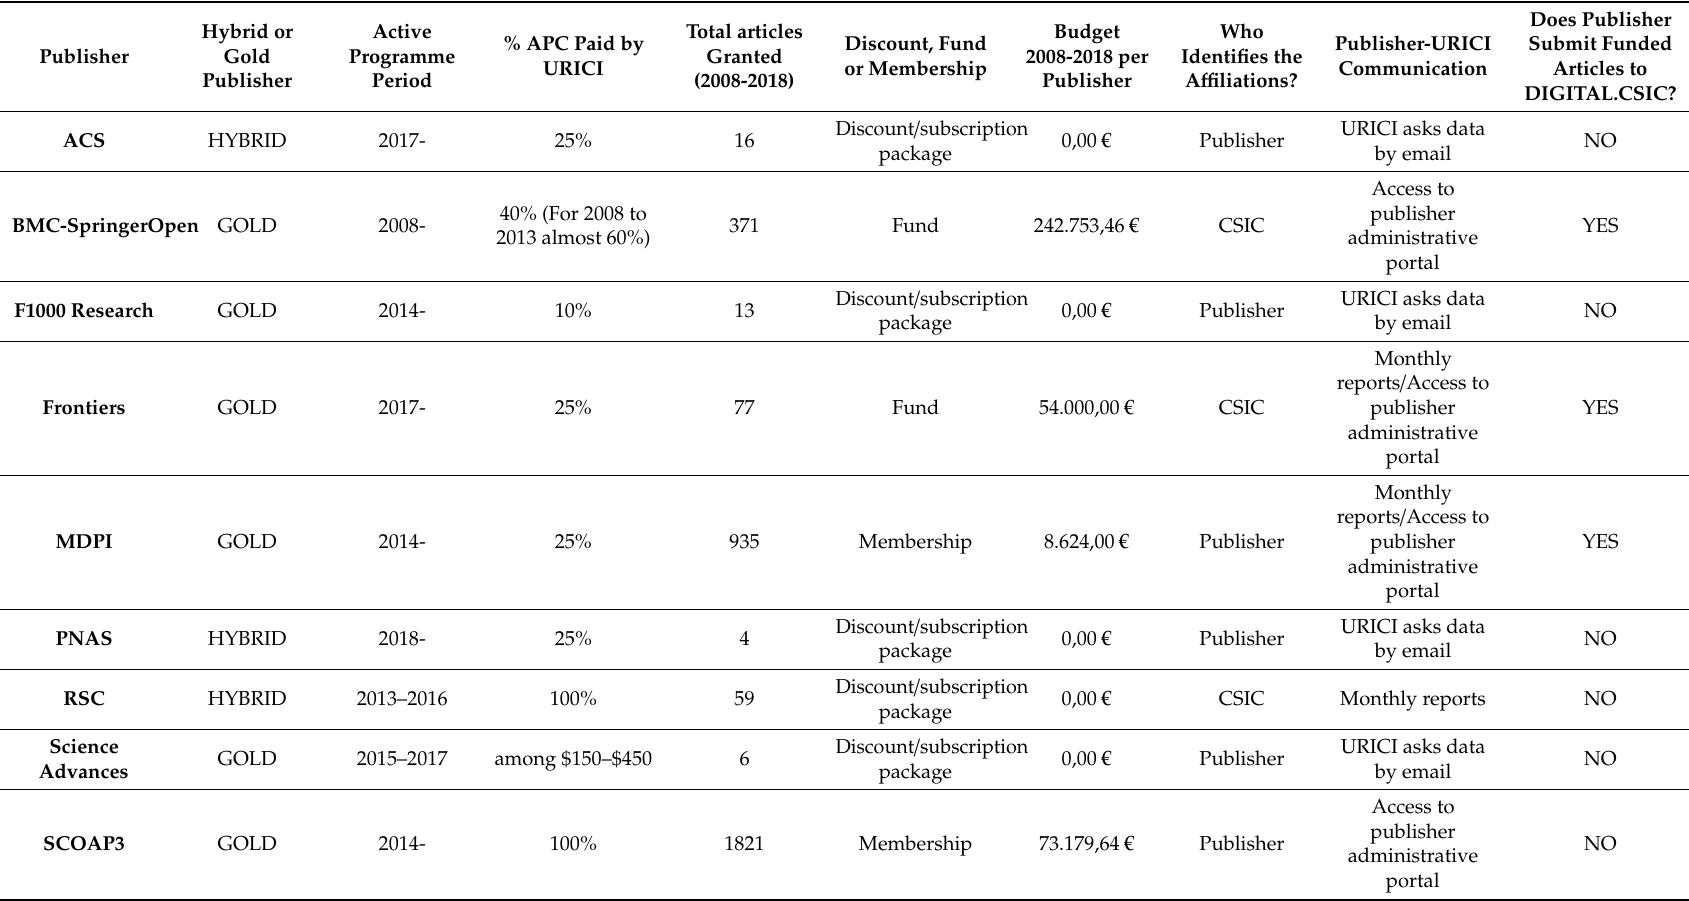
Table 1. Summary of CSIC Open Access Publishing Support Programme in